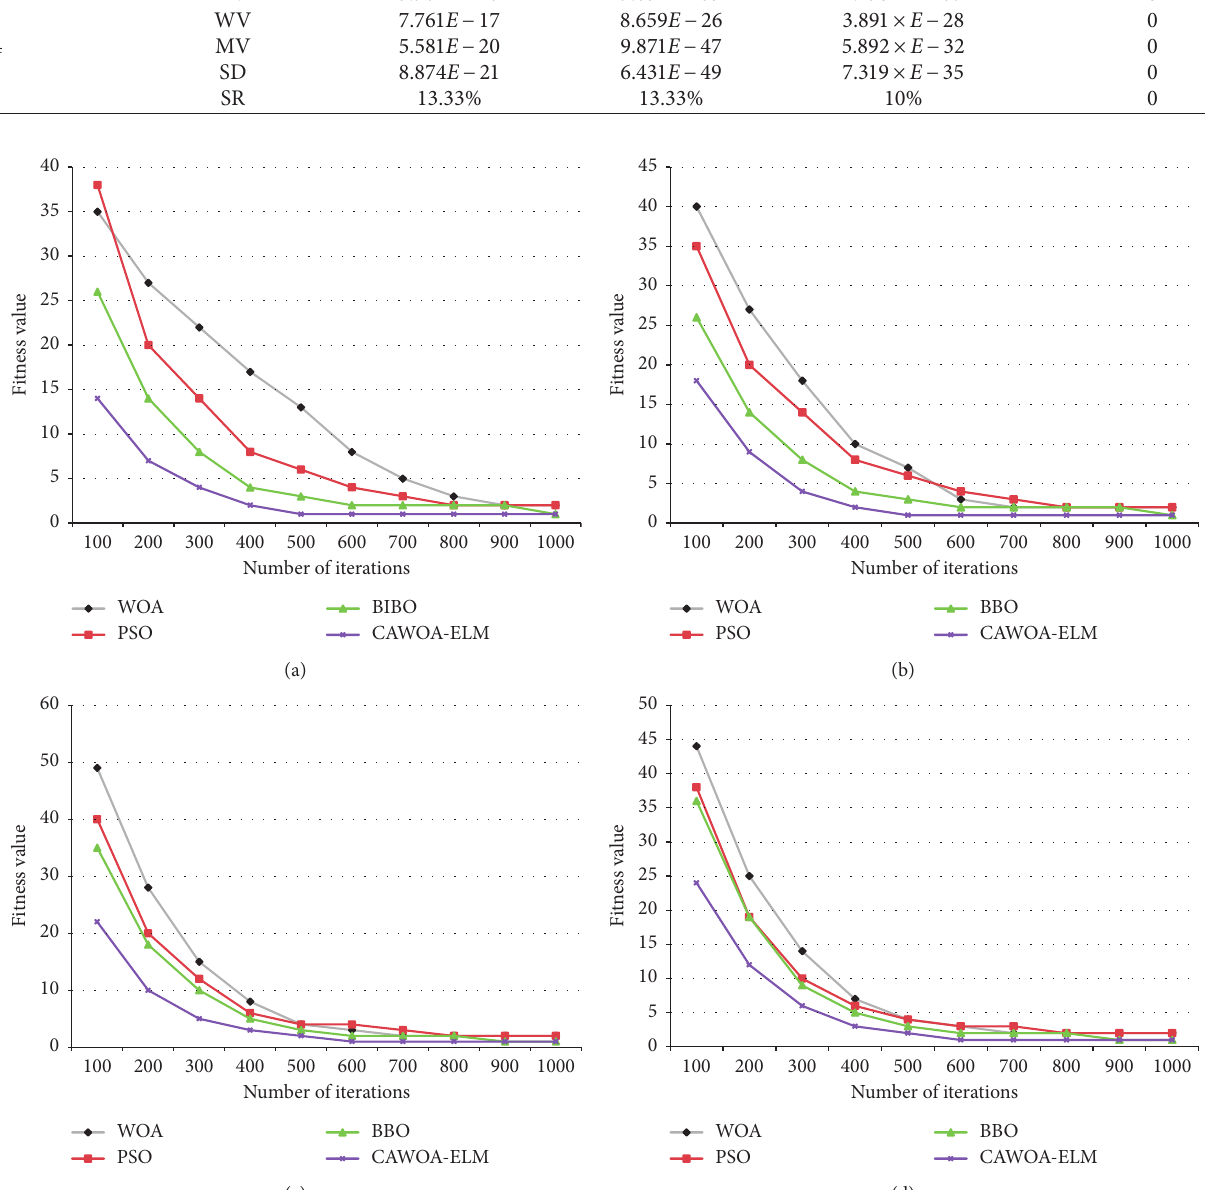
Figure 1: The algorithm convergence analysis (Dim �